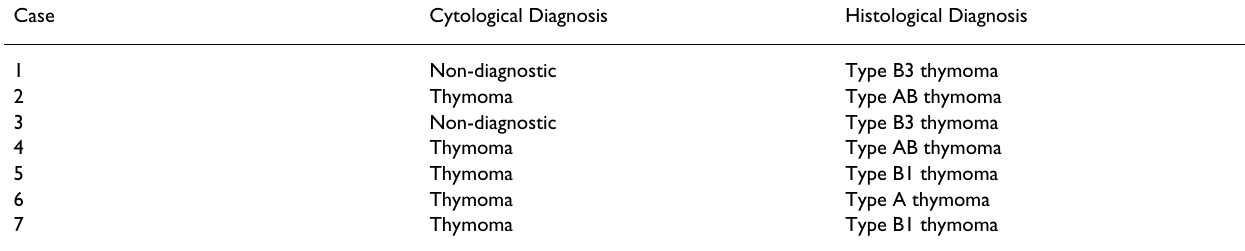
Table 1: Correlation of Cytological Diagnosis with Final Histological Diagnosis Case